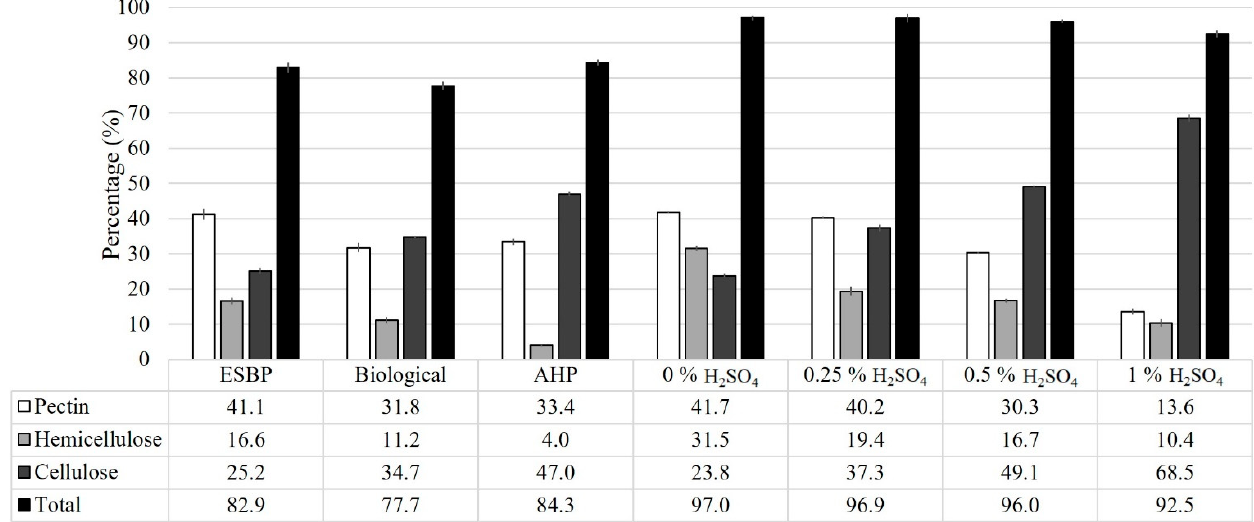
Figure 1. Fibre composition of exhausted sugar beet pulp (ESBP) in dry basis (% w / w ): non-pretreated ESBP (ESBP), biologically pretreated ESBP (biological), alkaline hydrogen peroxide pretreated ESBP (AHP) and thermochemical acid pretreated ESBP with sulphuric acid (H 2 SO 4 ) using four concentrations (0, 0.25, 0.5 and 1% w / v ). The “total” shows in the figure is the sum of pectin, hemicellulose and cellulose, not being considered other components like lignin, salts or fats. The sum of all the components is 100% w/w in all the pretreatments.